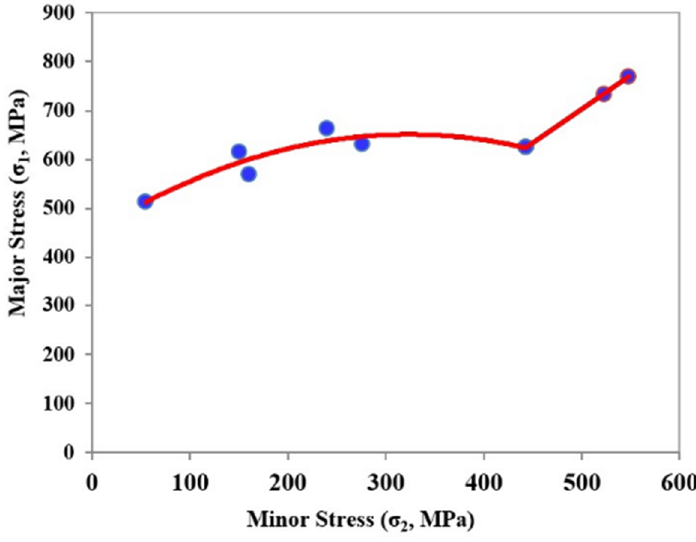
Table 2. When the principal directions of the stress tensor correspond with the anisotropic axes ( σx = σ 1, σy = σ 2, τxy = 0), the yield theory can be presented as the principal stress.